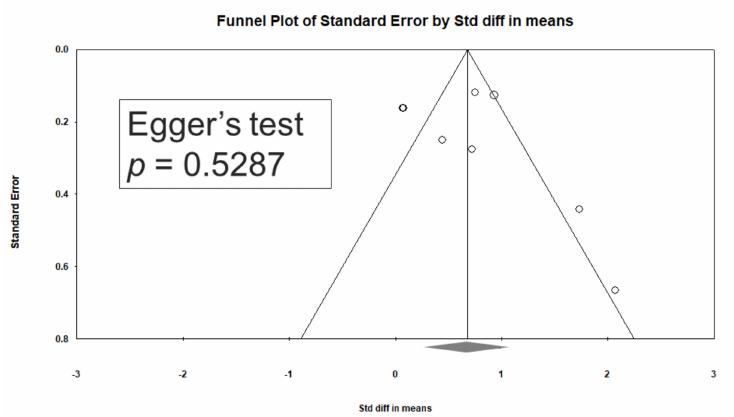
Figure 4. Funnel plots of d -serine levels. (Note: in the graph, the observed studies are shown as open circles, and the observed point estimate in log units is shown as a